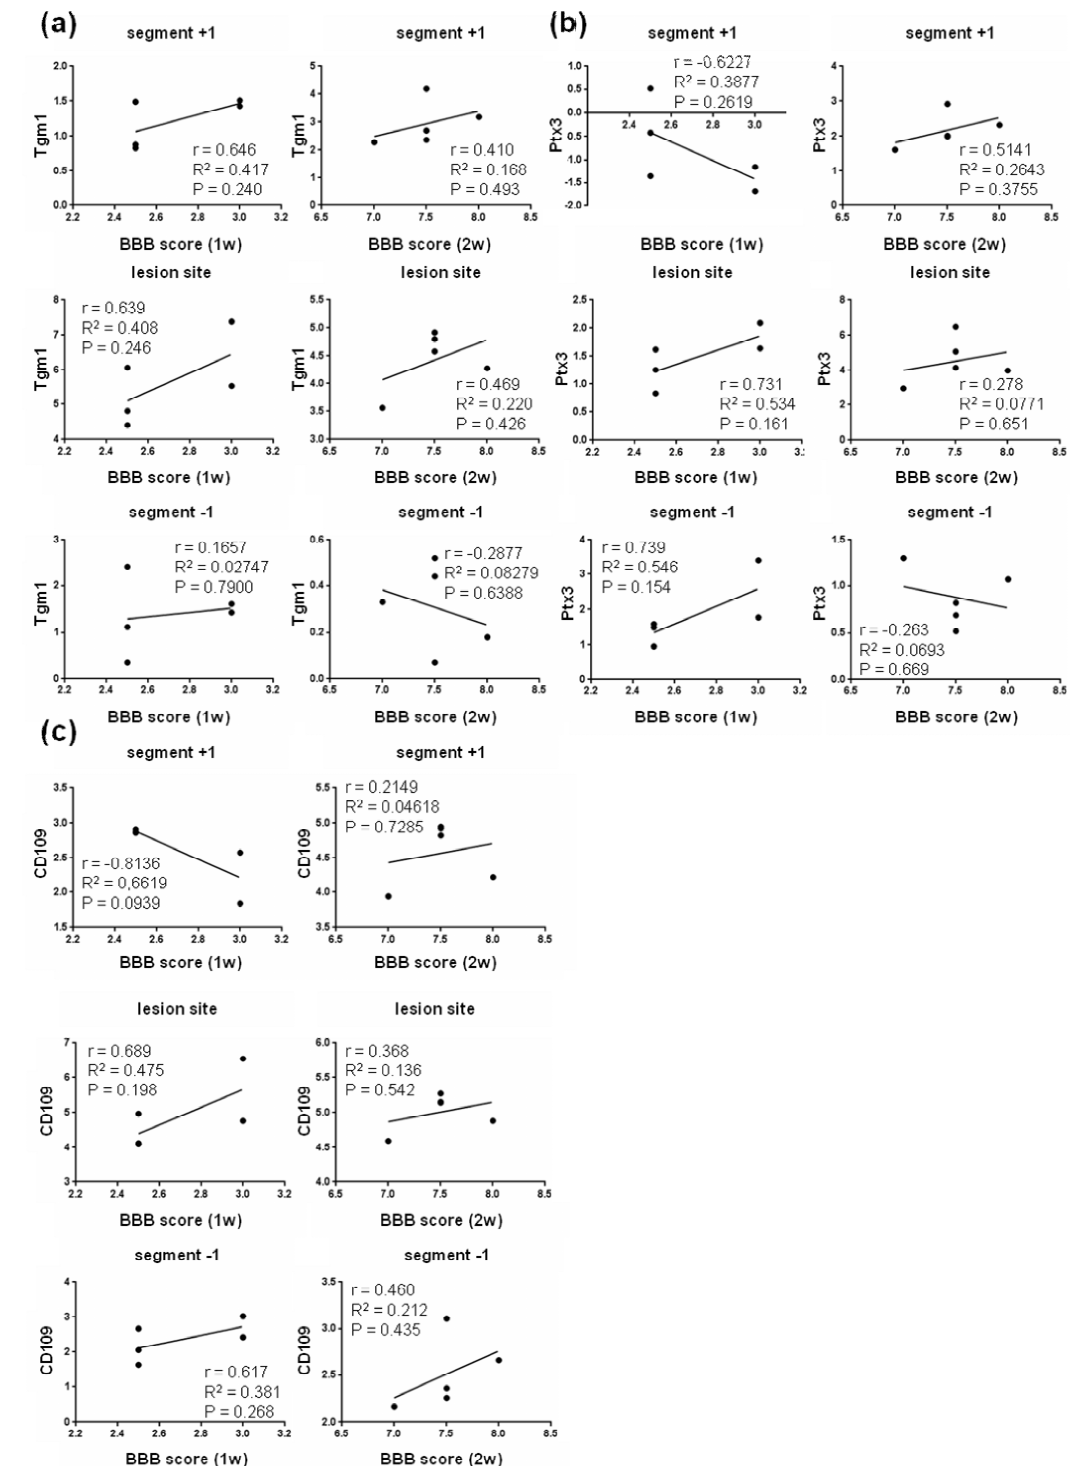
Figure 11. Correlation analysis of relative gene expression of neuroprotective A2 astrocyte markers Tgm1 ( a ), Ptx3 ( b ) and CD109 ( c ) in the cranio–caudal extent of the spinal cord versus BBB neurological scores at one and two weeks post-SCI. Scatterplots of individual values ( n = 5) with regression line correlation coefficient (r), coefficients of determination (r2) calculated using regression analysis and p -value. SCI—spinal cord injury; Tgm1—Transglutaminase 1; Ptx3—Pentraxin 3; CD109—Cluster of differentiation